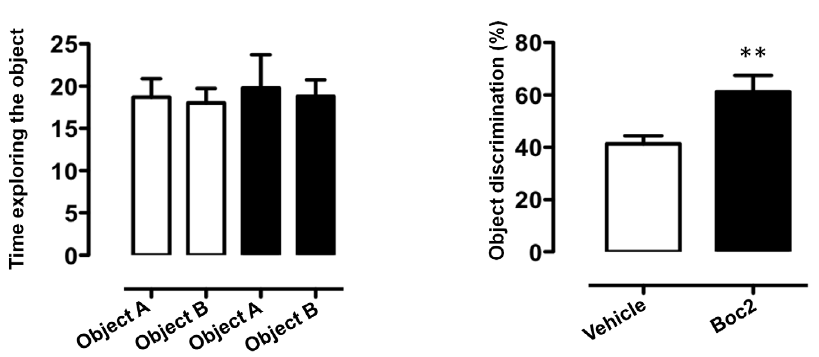
Fig. 8. Boc2-treatment increases the recognition of a novel object in C57BL/6 mice. The bar graphs show the total time (seconds) spent exploring the objects used in the test during the 10-minute acquisition phase (left panel) and the % of time spent on the novel object in the subsequent 5-minute test phase (right panel) of Boc2-treated mice compared to PBS vehicle-treated mice. Values are expressed as median ¡ S.E.M. and representative of four different experiments involving 6 mice per group. ** P , 0.01 indicates significant values compared to PBS-vehicle treated mice (Mann–Whitney U